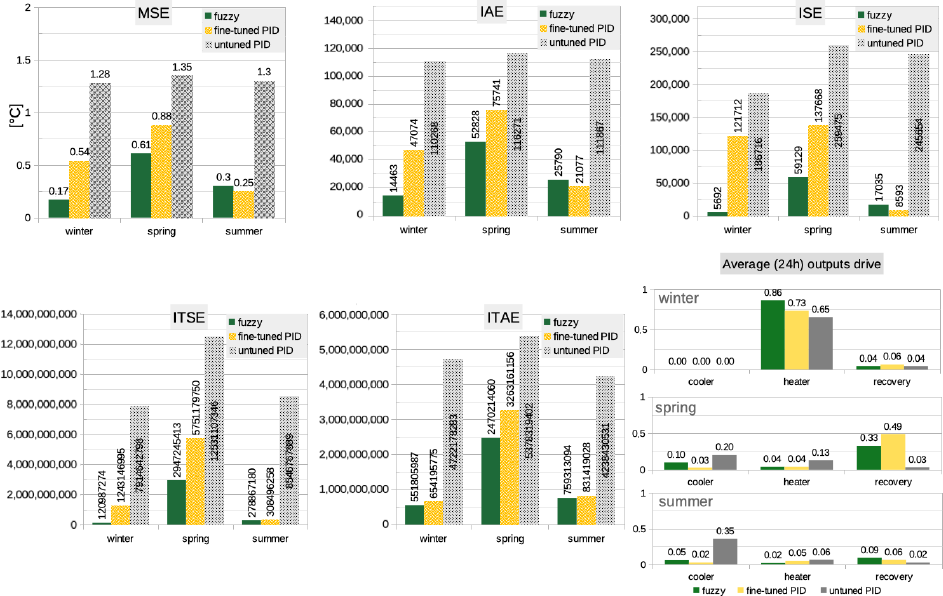
Figure 14. The graphical comparison of the averages of control quality indicators, errors and outputs drive for investigated cases (3 seasons, 2 room sizes).